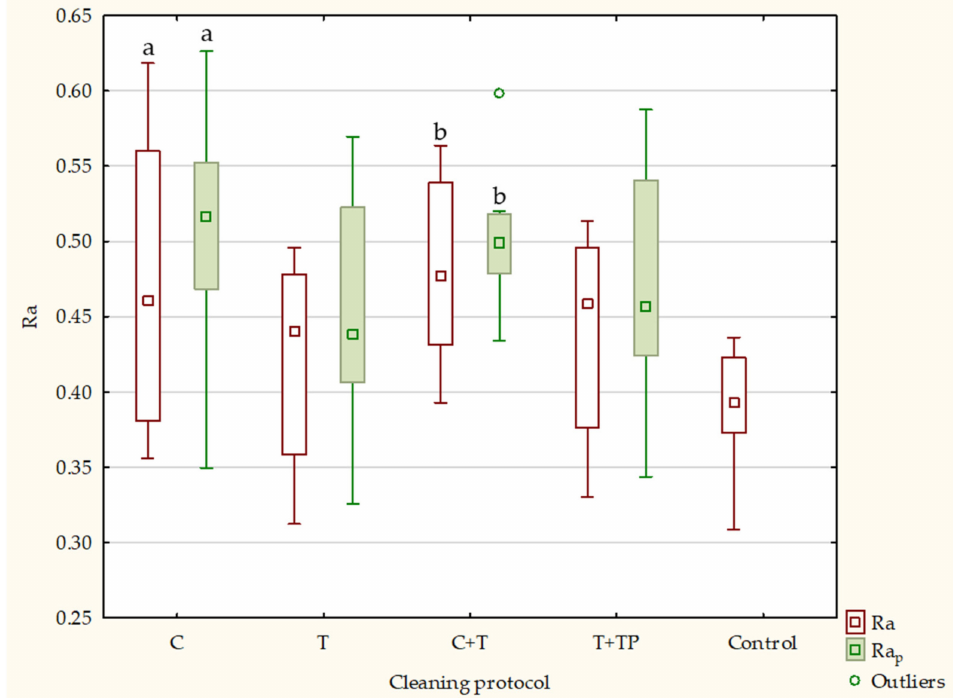
Figure 5. Surface roughness of the Biolon bottom side in different cleaning protocols; median, box: 25–75%, whisker: non-outlier range; C—Corega, T—toothbrush, TP—toothpaste, Rap—surface roughness after cleaning protocol; a p = 0.012889, b p =